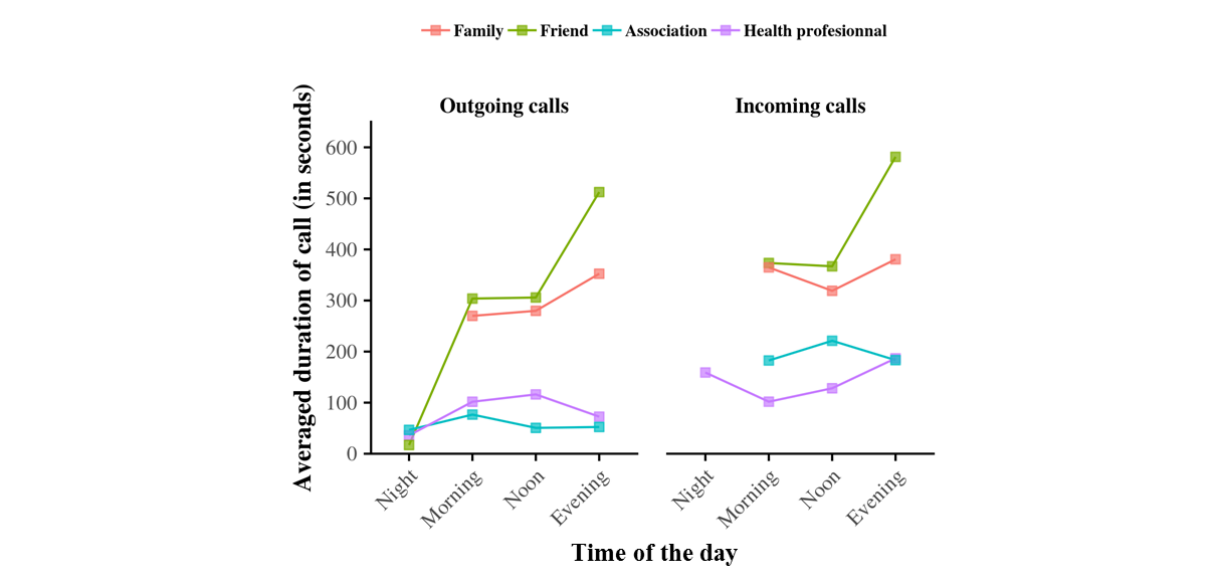
Figure 9. Average duration of telephone calls between egos and their social network during the day. Data show the average duration of telephone conversations between egos and their family (red), friends (green), health professionals (purple), and associations